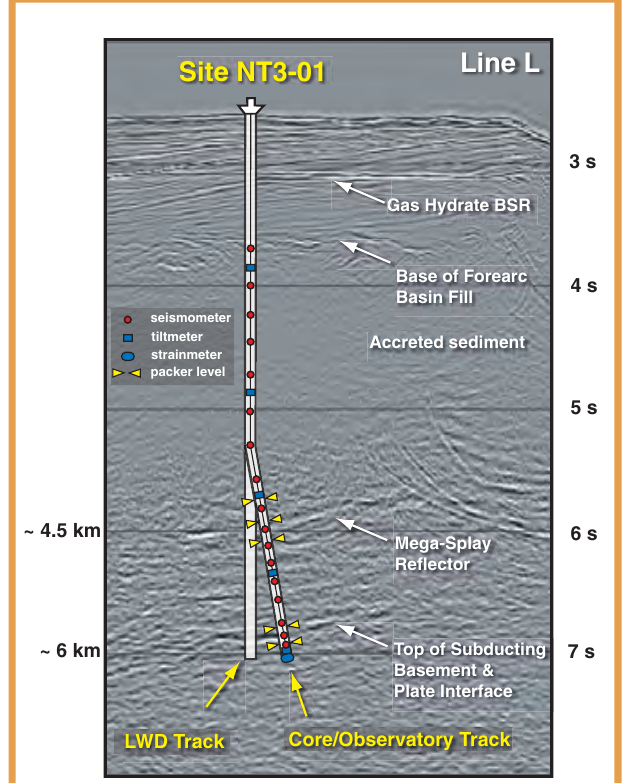
Figure 3. Conceptual drilling and long-term observatory plan for the deepest site, NT3-01. Drilling is planned to proceed with a mix of LWD and coring with casing to total depth, followed by sidetracking to core the prime fault targets and install monitoring instrumentation. Sensors shown here are positioned schematically. A number of sensor elements are not shown for clarity, including temperature arrays, and fl uid pressure sensors. Packers isolate perforated zones for fluid communication to the formation above, below, and inside each of the 2 target fault zones. Depths are based on Line 5 in Fig. 2. The borehole deviation is shown conceptually and is not meant to represent true angle or